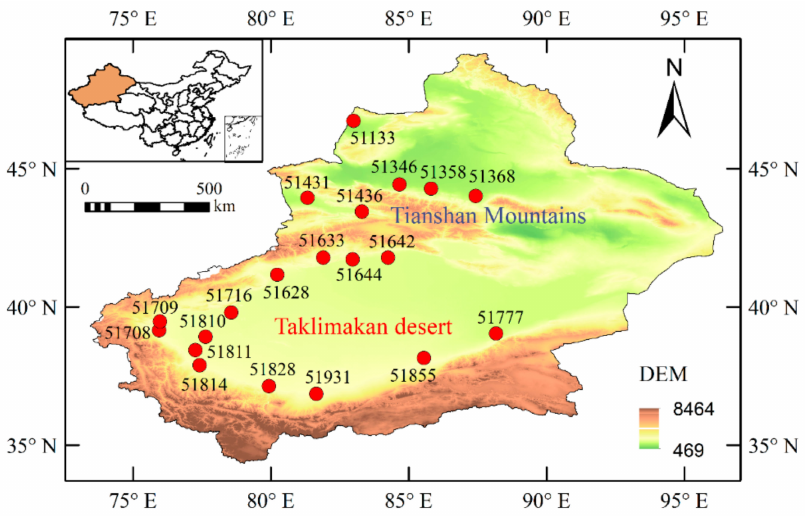
Figure 1. Location and elevations (m) of the selected 20 agro-meteorological sites in Xinjiang,